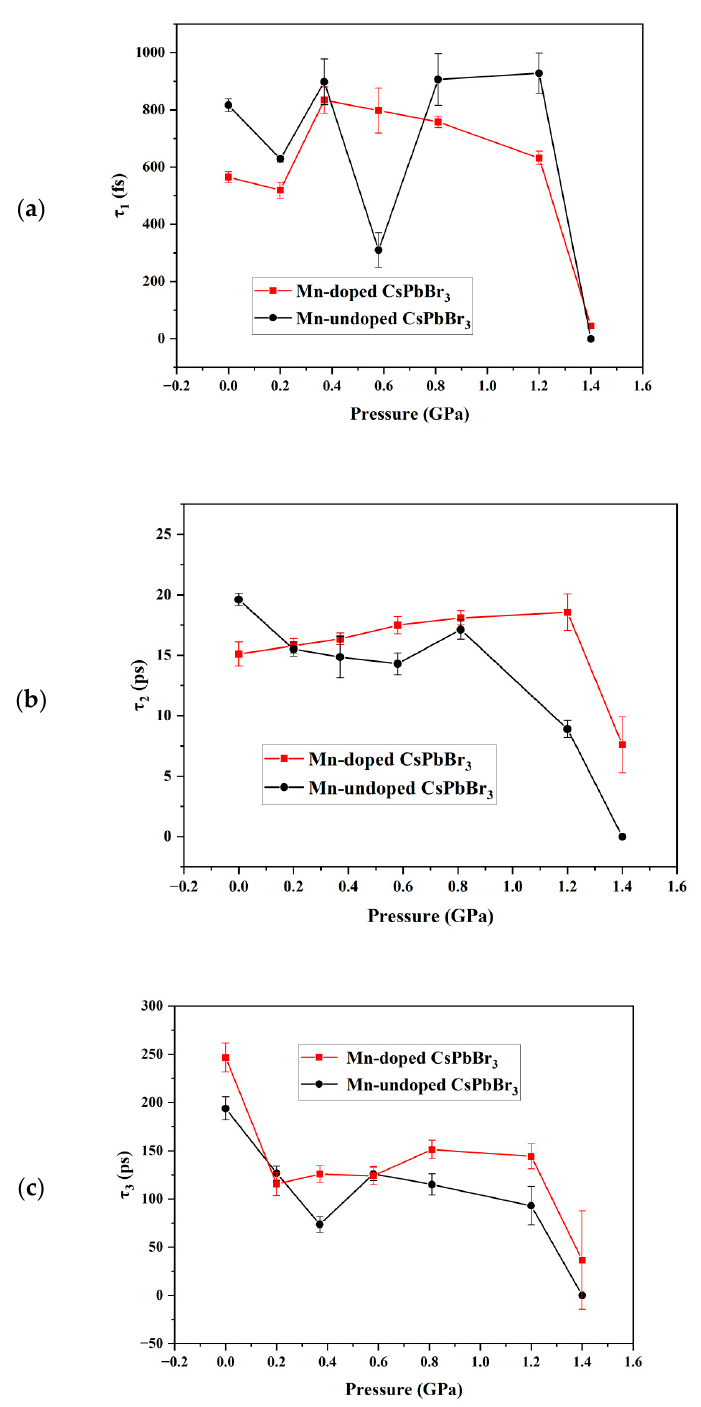
Figure 7. ( a – c ) present the time constants of global fitting of transient absorption spectra of Mn-doped and undoped CsPbBr 3 under different pressures.